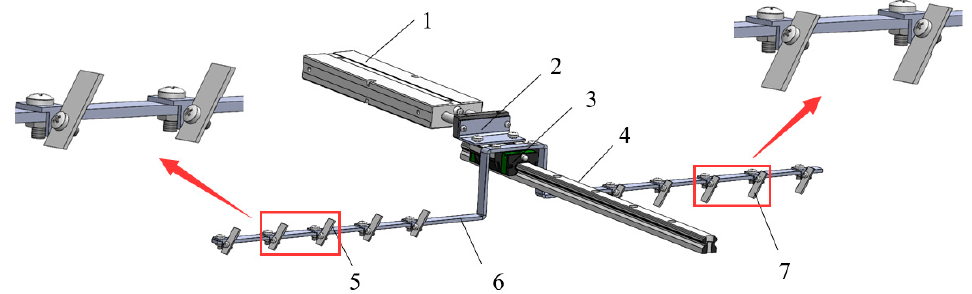
Figure 11. Full-tray, synchronous cutting device. 1. Biaxial cylinder; 2. Connecting block; 3. Slider;